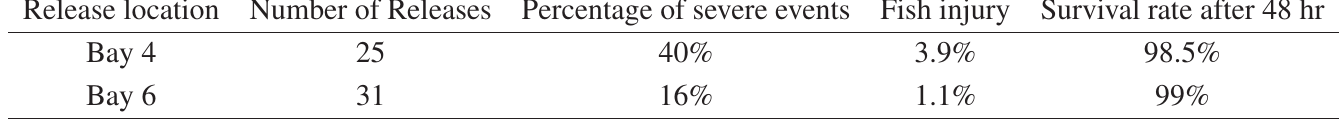
Table 1 . Summary of Sensor Fish releases from entry point to baffle blocks and comparison with live test fish results. Live fish results were adapted from